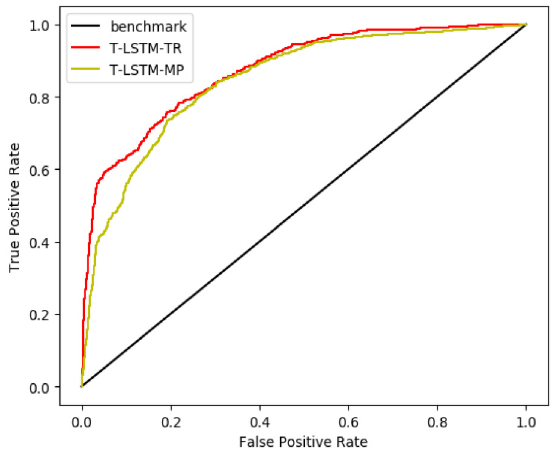
Figure 6. ROC curve of T-LSTM-TR and